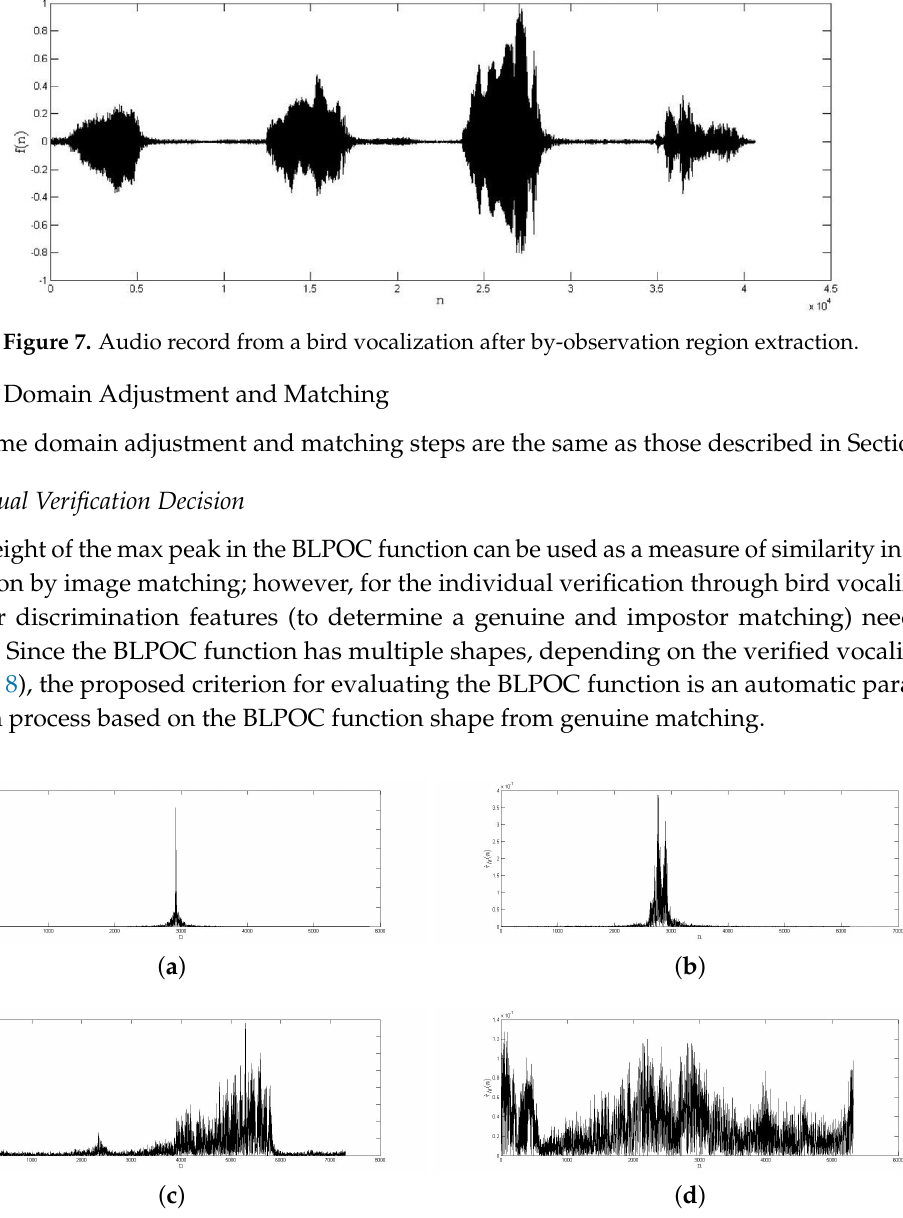
Figure 8. Examples of genuine and impostor matching: ( a ) BLPOC function between two identical bird vocalizations from the same individual; ( b ) BLPOC function between two similar vocalizations from the same individual; ( c ) BLPOC function between two similar vocalizations from two different individuals from same bird species; and ( d ) BLPOC function between two different individuals from different bird